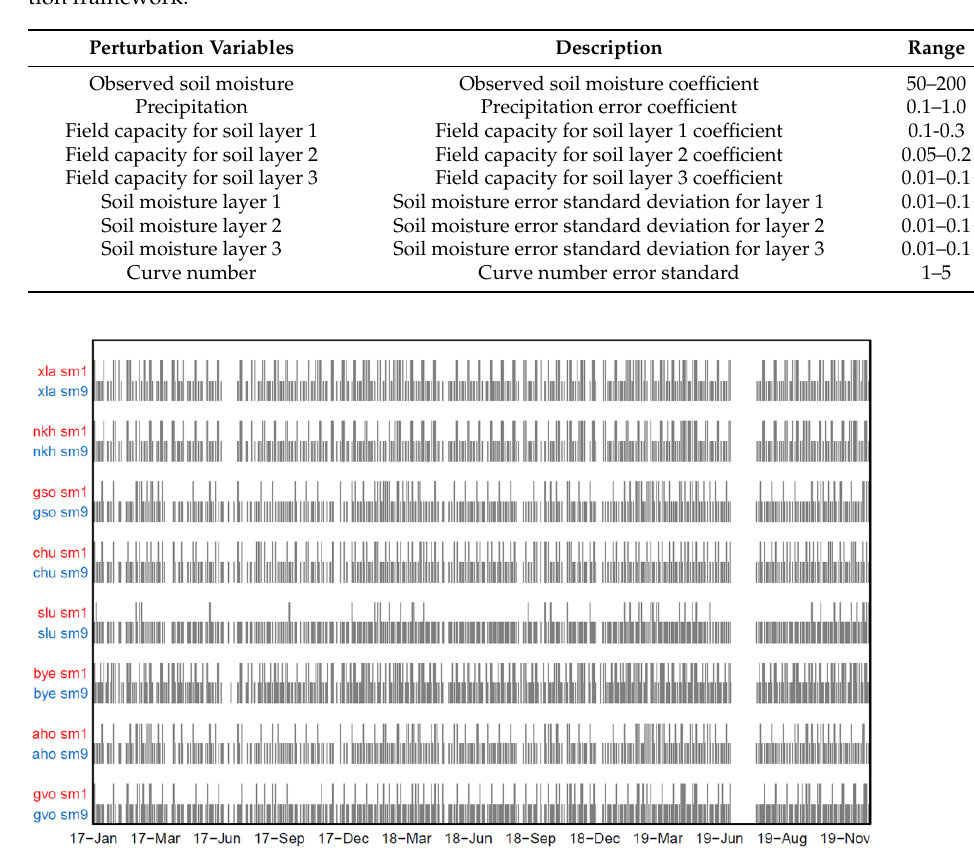
Figure A1. Available soil moisture (grey rectangular) for SMAP 9 km (SM9) and downscaled SMAP 1 km (SM1) at each catchment during 2017–2019. The y-axis label is written as hydrological station name and soil moisture products. An available soil moisture day is counted as at least 30% of basin area has soil moisture